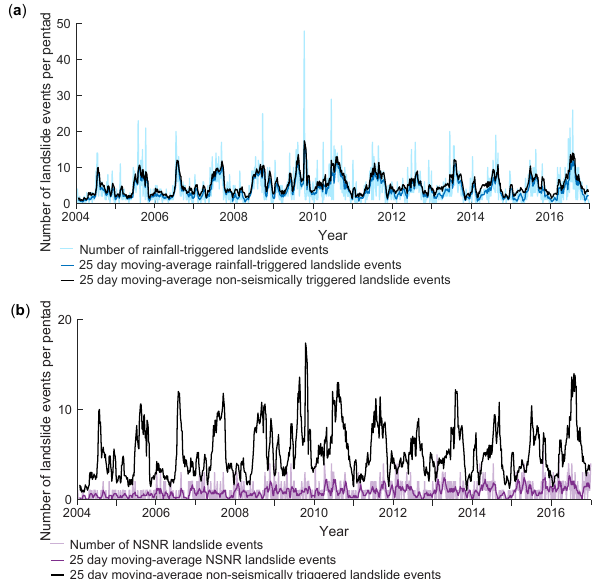
Figure 3. (a) The occurrence of rainfall-triggered landslide events from 2004 to 2016 (blue). The data are arranged by pentads (5-day bins), starting on 1 January each year. A simple 25-day moving av- erage is shown. The 25-day moving average for all non-seismically triggered landslide events is shown in black. (b) The occurrence of NSNR landslide events from 2004 to 2016 (purple). The data are arranged by pentads (5-day bins), starting on 1 January each year. A simple 25-day moving average is shown. The 25-day moving av- erage for all non-seismically triggered landslide events is shown in black.